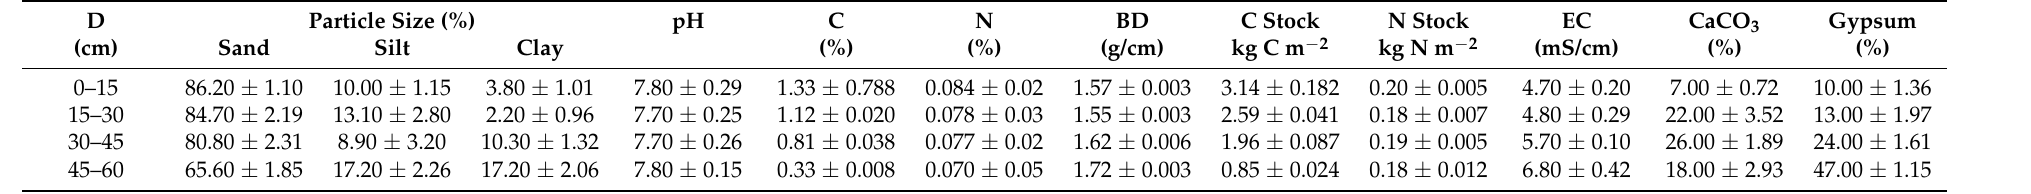
Table 1. General soil properties in study site, September 2019 (n =